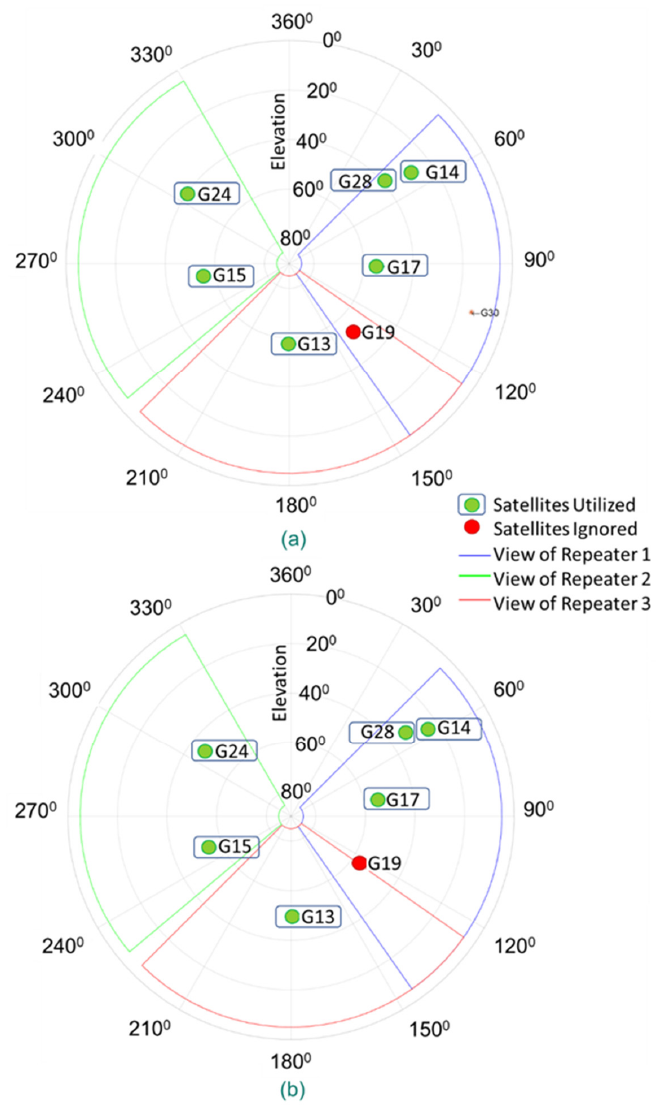
Figure 12. Satellites in each repeater’s angle of view in Experiments ( a ) 1 and ( b )